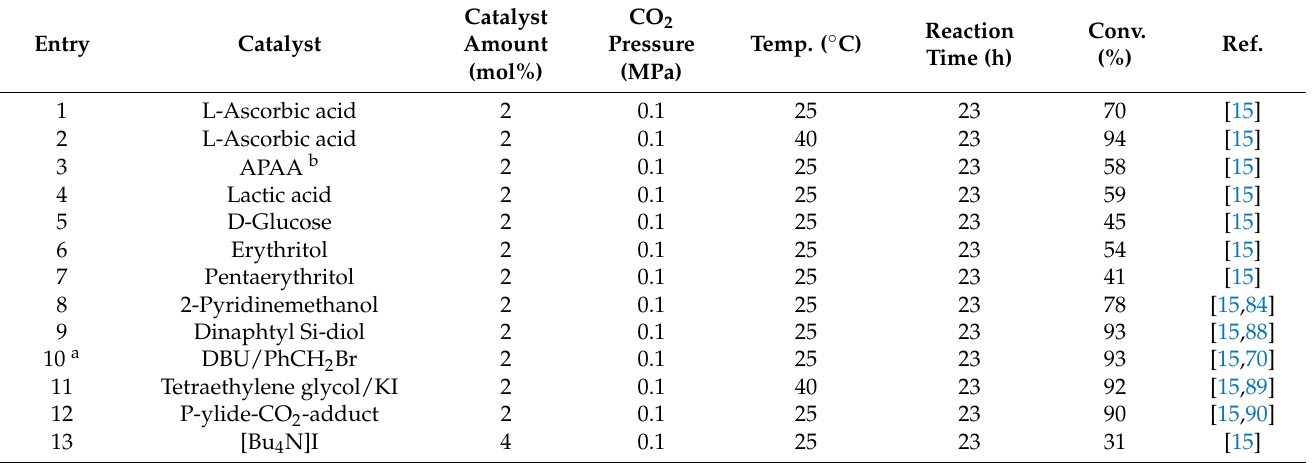
Table 20. Comparison of various HBD/Bu 4 NI catalytic systems for the carbonation of EPIC.